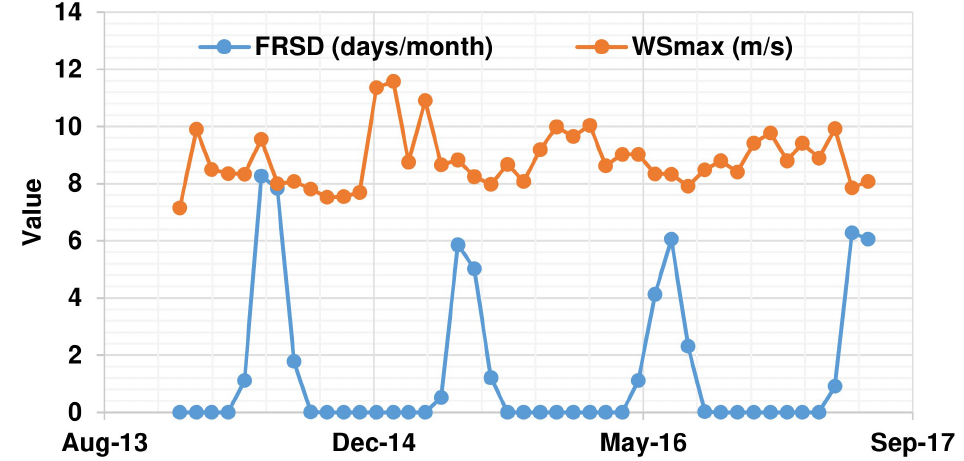
Figure 6. Historical trend of FRSD and WS.